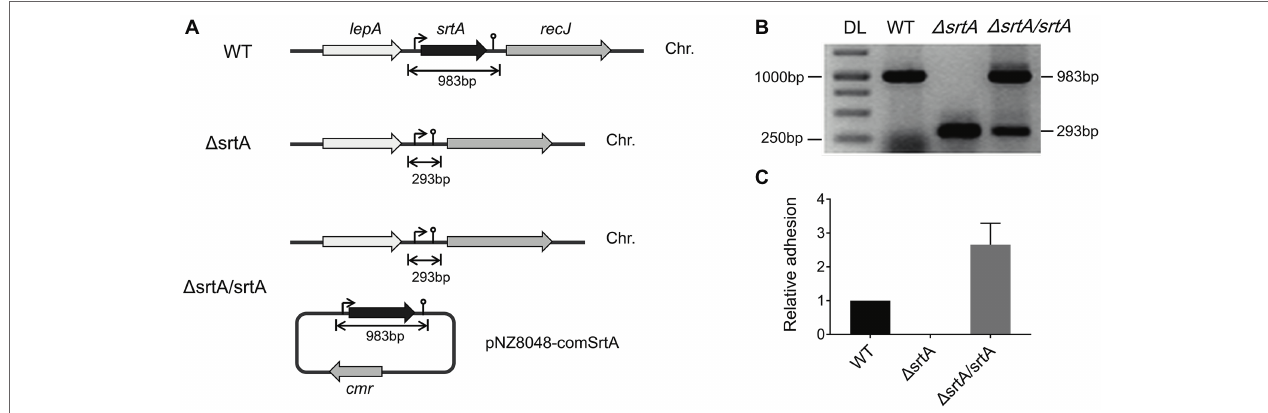
FIGURE 1 | Generation of a srtA deletion mutant ( ∆ srtA) and a complemented strain ( ∆ srtA/srtA) in L. gasseri Kx110A1 (WT). (A) Schematic diagram of srtA inactivation in L. gasseri and generation of a complemented strain. The lepA , gene encoding the GTP-binding protein LepA; srtA , gene encoding sortase A; recJ , gene encoding exonuclease RecJ; cmr , chloramphenicol resistance gene; and Chr, chromosomal DNA. (B) PCR products separated by agarose gel electrophoresis. The srtA mutant and complemented strain were analyzed and verified by PCR using the primer pair comSrtA-F/R. DL, DNA ladder. (C) The srtA transcript level quantified by qPCR using the primer pair